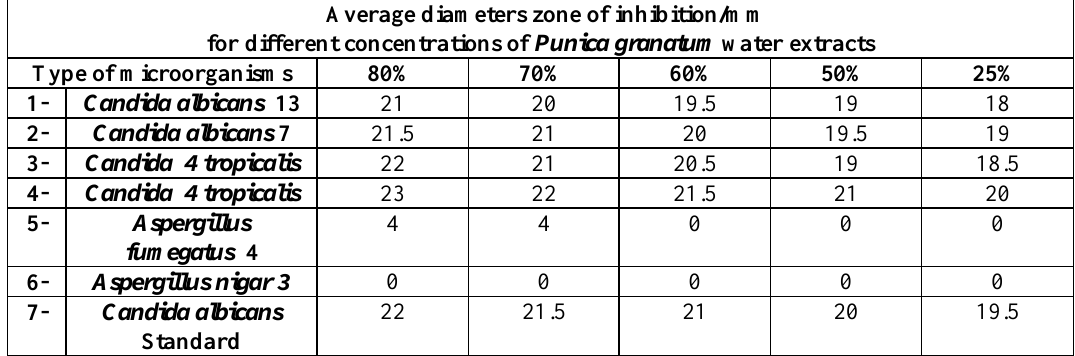
Table (3) - Diameters Zone of Inhibition /mm of Fungi Under test (Water Extracts ) Average diameters zone of inhibition/mm